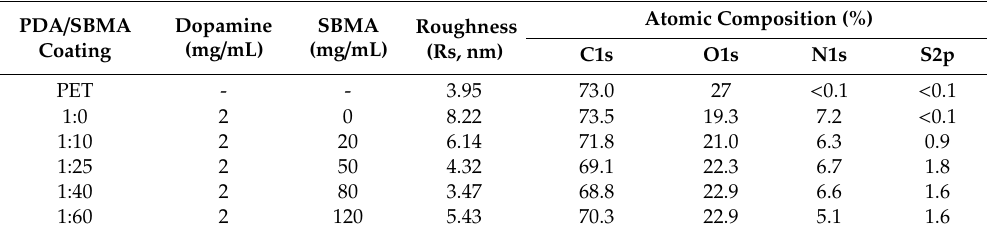
Table 1. Formula, roughness, and element composition of the PDA / SBMA coatings. PDA, polydopamine; SBMA, sulfobetaine